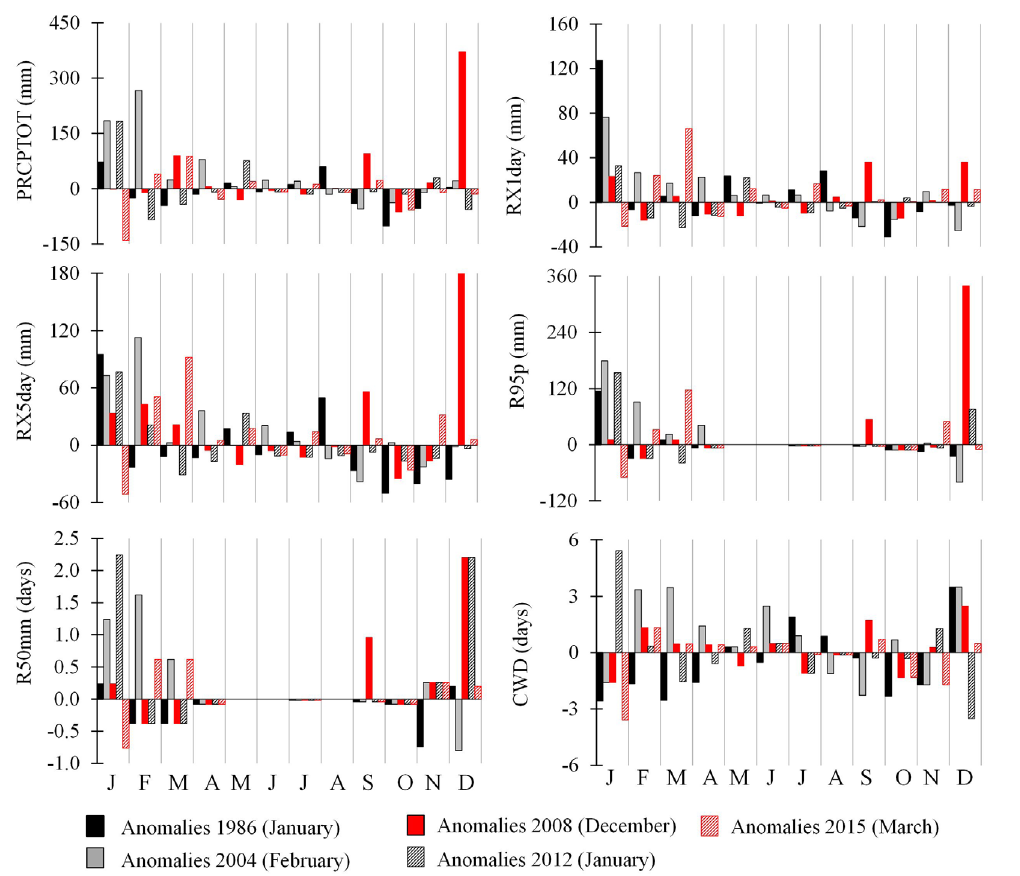
Figure 9. Monthly distribution of anomalies of extreme precipitation indices in years with natural disasters occurred: 1986 (January), 2004 (February), 2008 (December), 2012 (January) and 2015 (March); month between parentheses indicate the month floods or landslides happened. Anomalies are computed with respect to the 1968–2017 climatological mean for each